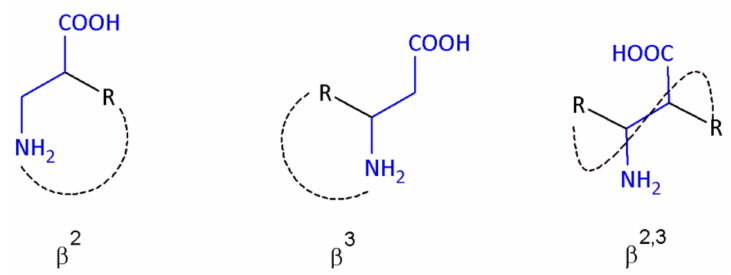
Figure 1. Schematic presentation of different β -amino